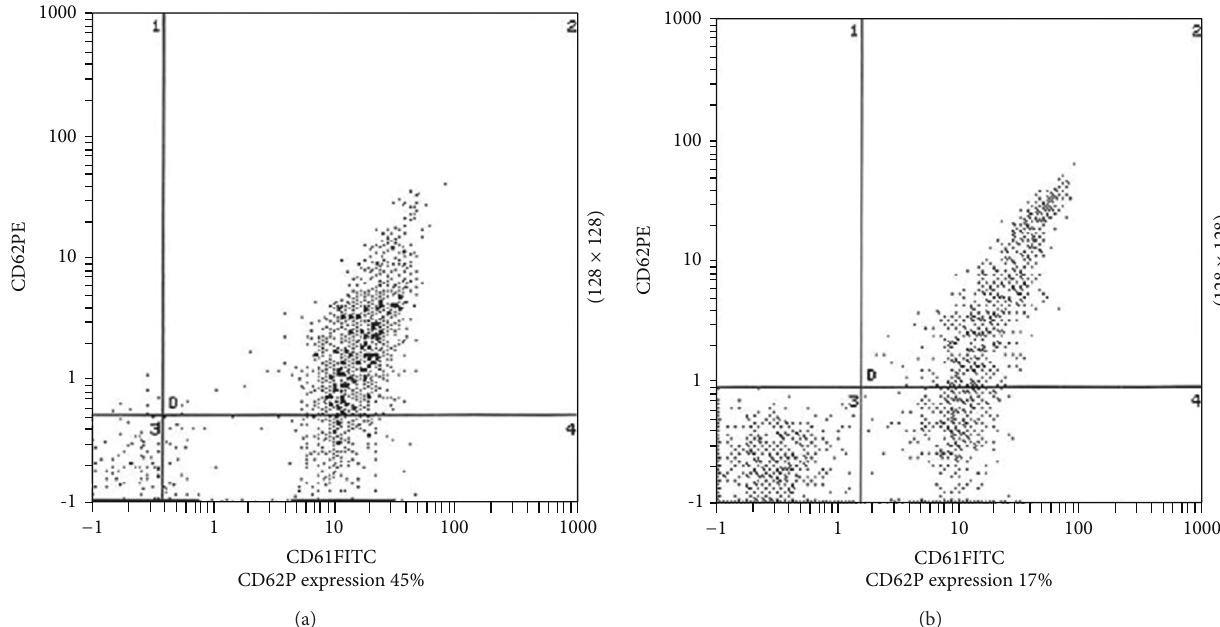
Figure 7: Flow cytometric detection of P-selectin in (a) diabetic patient and (b) nondiabetic patient (adapted from Saad et al., 2011 [34]).